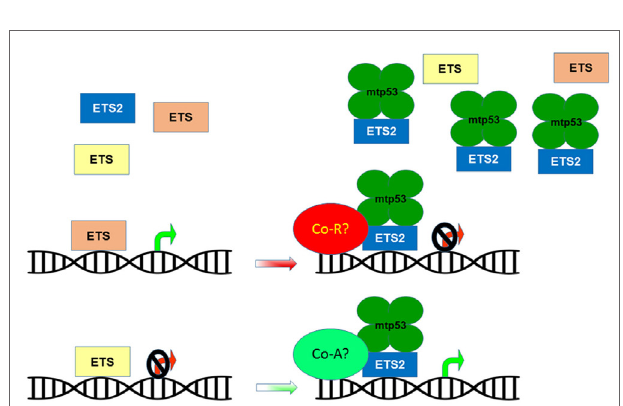
FiGURe 2 | Mutant p53 disrupts eTS family target gene regulation . The ETS family of transcription factors share multiple target genes based on their ability to bind a common DNA motif. These shared targets can be regulated in a cooperative or opposing manner in order to maintain homeostatic control of gene expression. The presence of mtp53 causes ETS2 to accumulate and outcompete other ETS family members for binding to target genes, potentially altering their repression/activation by recruiting co-repressors (Co-R) or co-activators (Co-A).